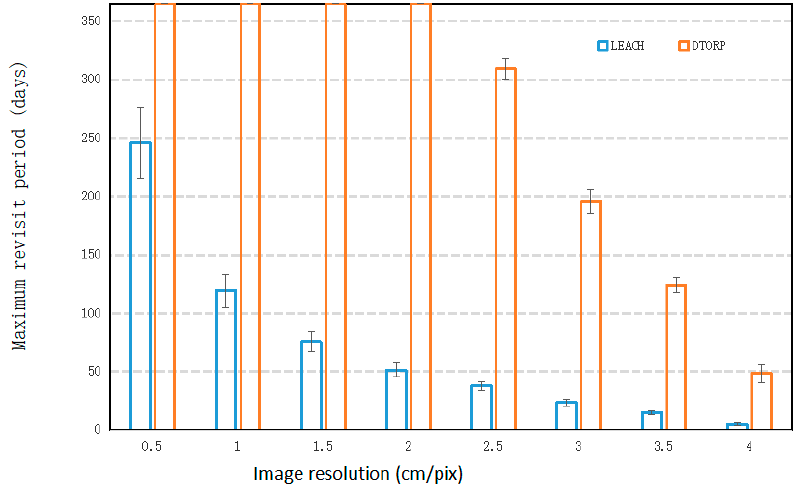
Figure 4. Maximum revisit period of the UAV-WSN systems with respect to the spatial image resolution.